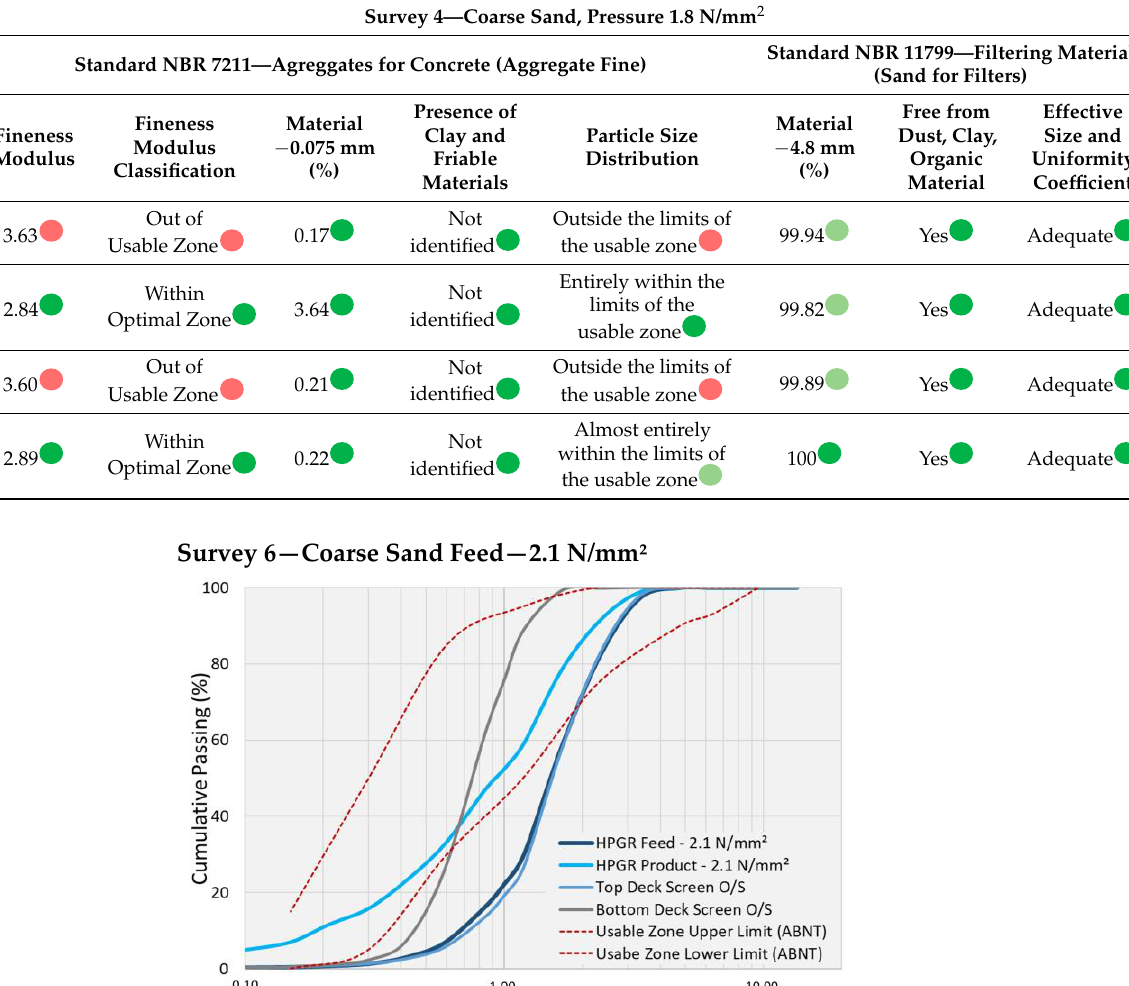
Table 8. Survey 1 product analysis.